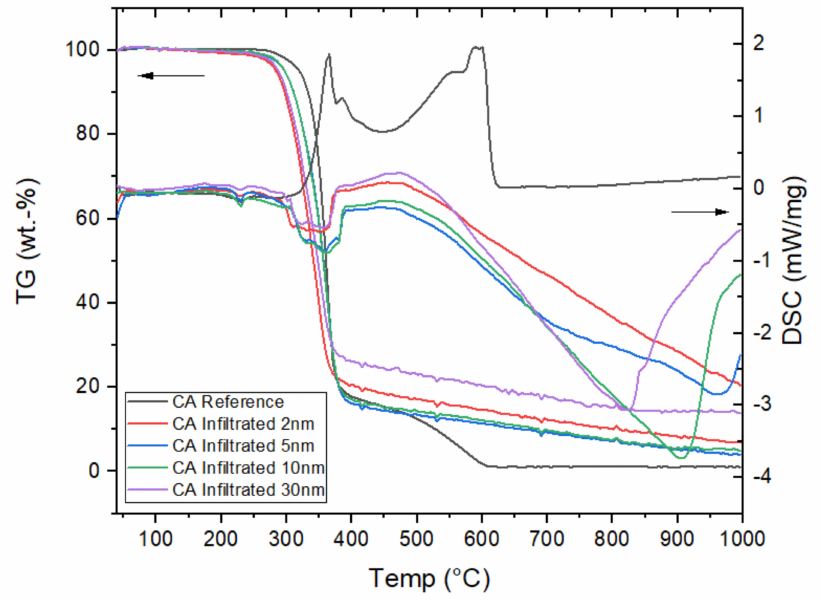
Figure 15. TGA and DSC curves of CA fibres with Al 2 O 3 of variable amounts infiltrated into them.